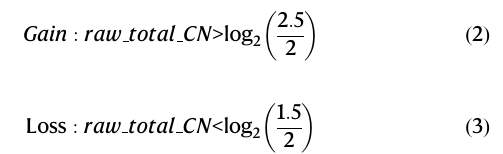
Fig. 5 | Co-existence of MYC ampli fi cation and SCNAs from the PI3K and RAS pathways in lung squamous and triple-negative p53-mutant breast cancers. Frequency plots showing the distribution of chromosomal ampli fi cations/homo- zygous losses (continuous line) or gains/heterozygous losses (shade) across the genome in both MYC-ampli fi ed/gain (pink for ampli fi cations/gains and blue for losses) and MYC diploid tumours (gray) in the Breast TCGA cohort ( a triple- negative invasive ductal p53-mutant tumours only), Breast Metabric cohort ( b triple-negative invasive ductal p53-mutant tumours only) and Lung Squamous TCGAcohort c .Thelocationofalistoffunctionalcancergenesselectedinref.49is indicatedontop.Cancergenesarecolour-codedingreeniftheybelongtothePI3K